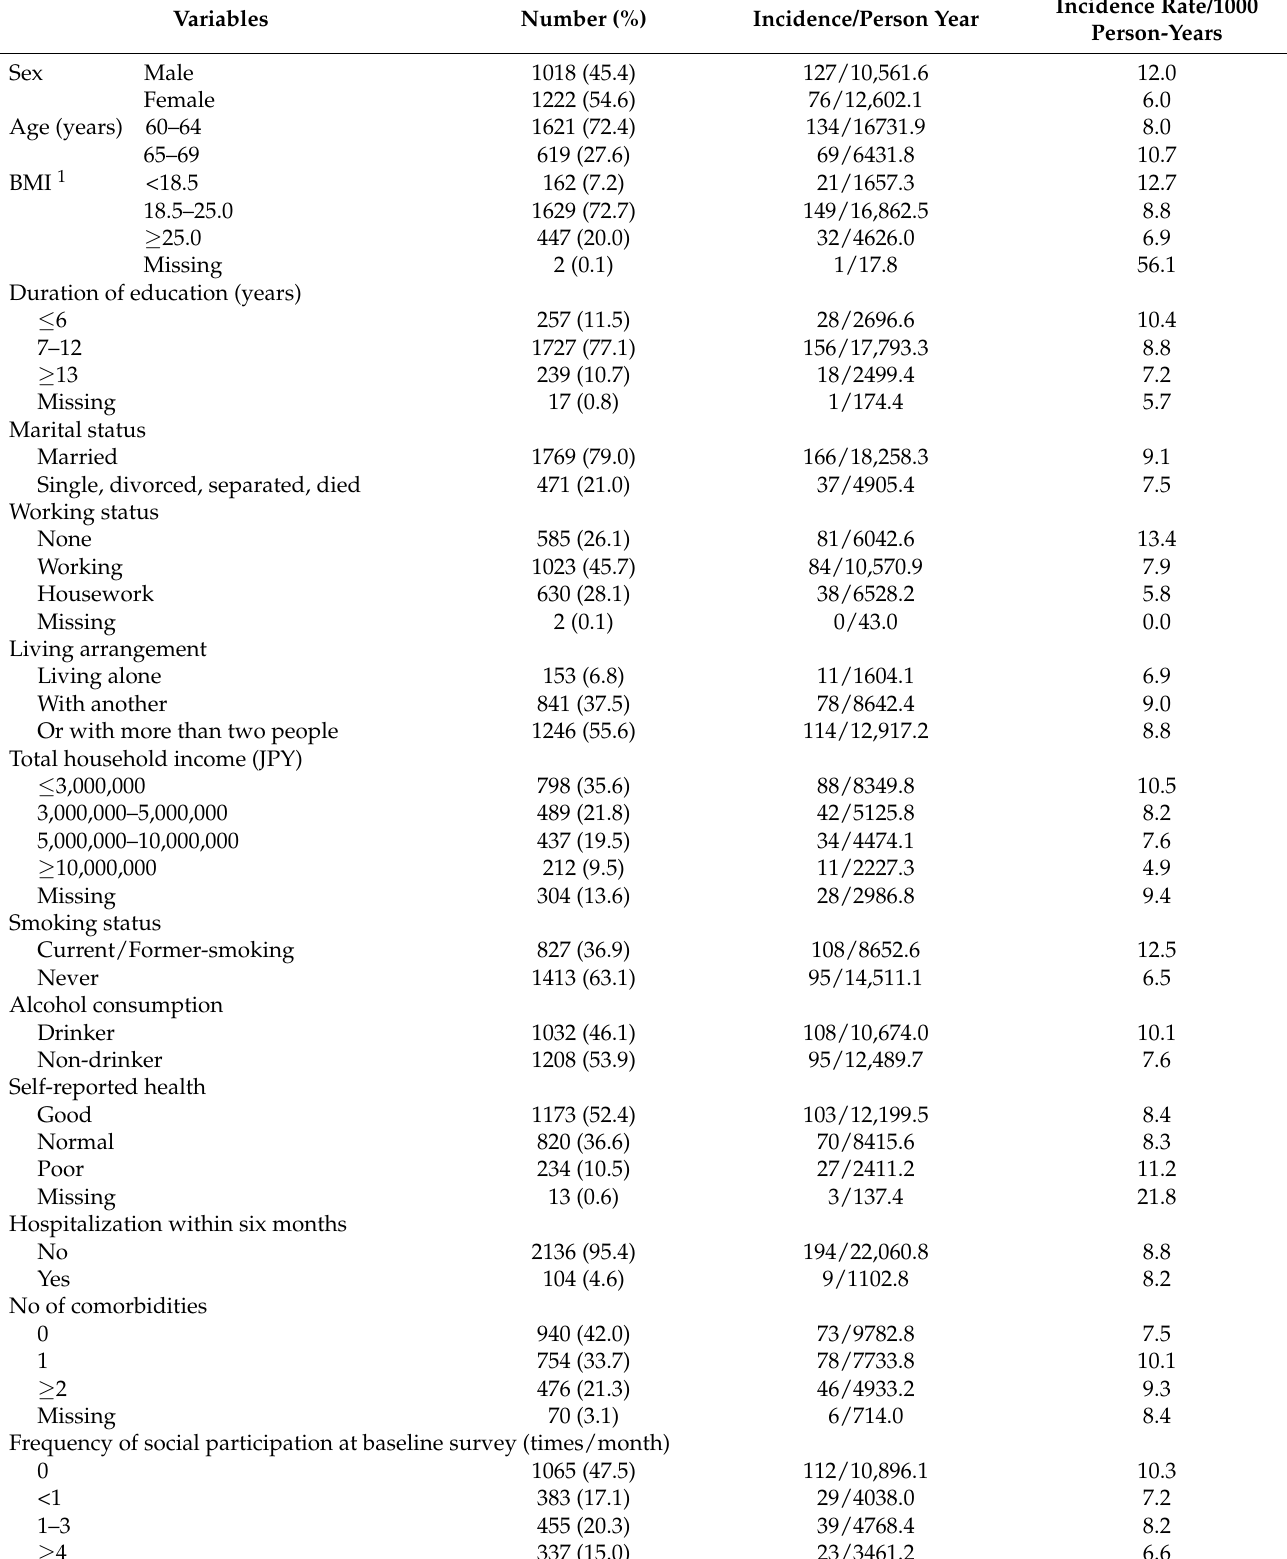
Table 1. Mortality rates by background characteristics of the study participants (N =